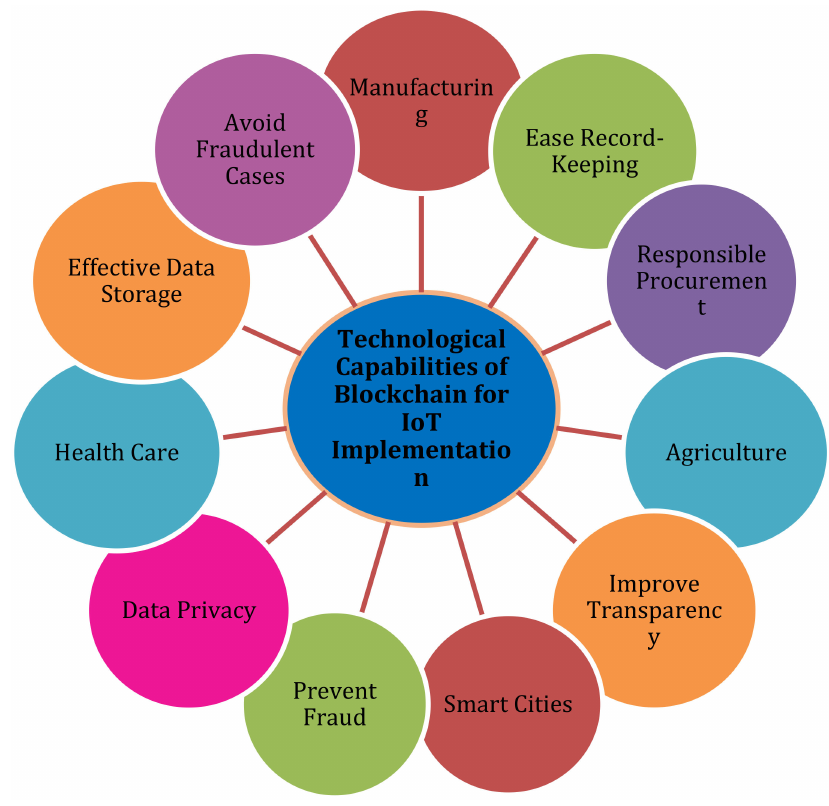
Figure 1. Capability of blockchains for IoT implementation in different